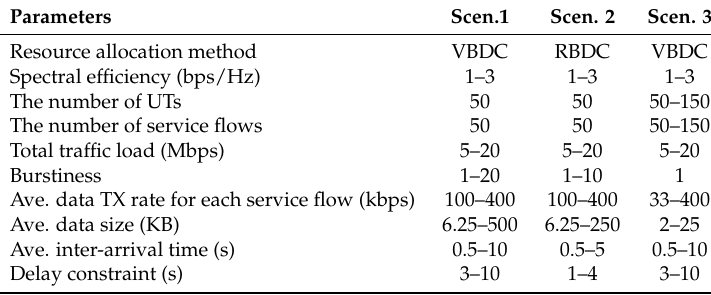
Table 2. The simulation scenario. VBDC, volume-based dynamic capacity; RBDC, a rate-based dynamic